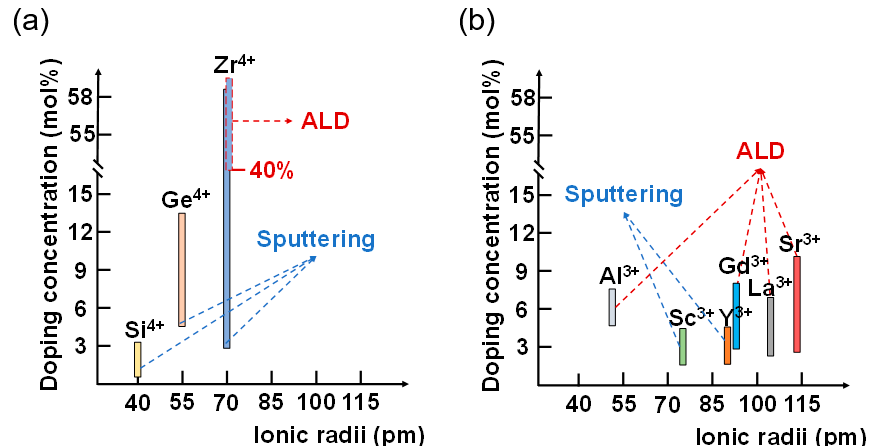
Figure 6. Summarized doping concentration and ionic radii of ( a ) quadrivalent (Si, Ge, Zr) and ( b ) trivalent (Al, Sc, Y, Gd, La, Sr) dopants that make HfO 2 films ferroelectric [22,23].